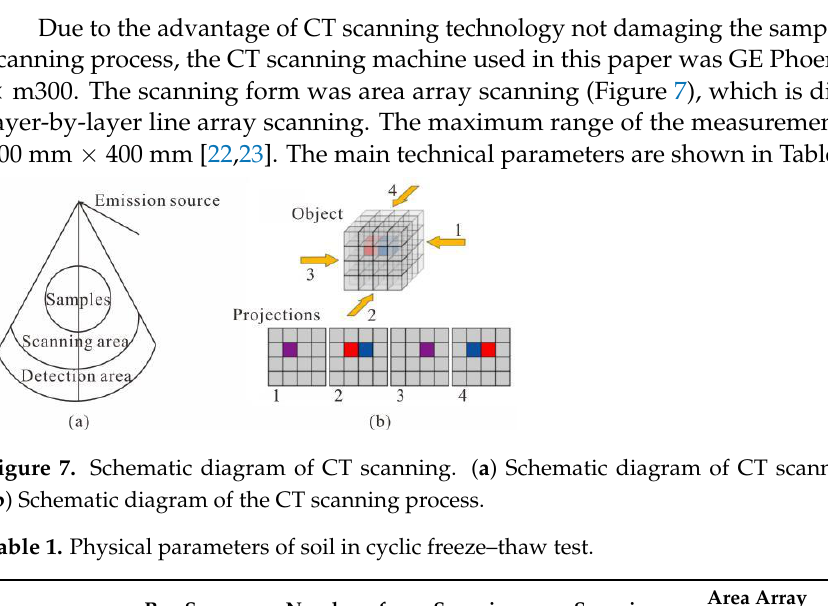
Figure 7. Schematic diagram of CT scanning. ( a ) Schematic diagram of CT scanning principle. ( b ) Schematic diagram of the CT scanning process.